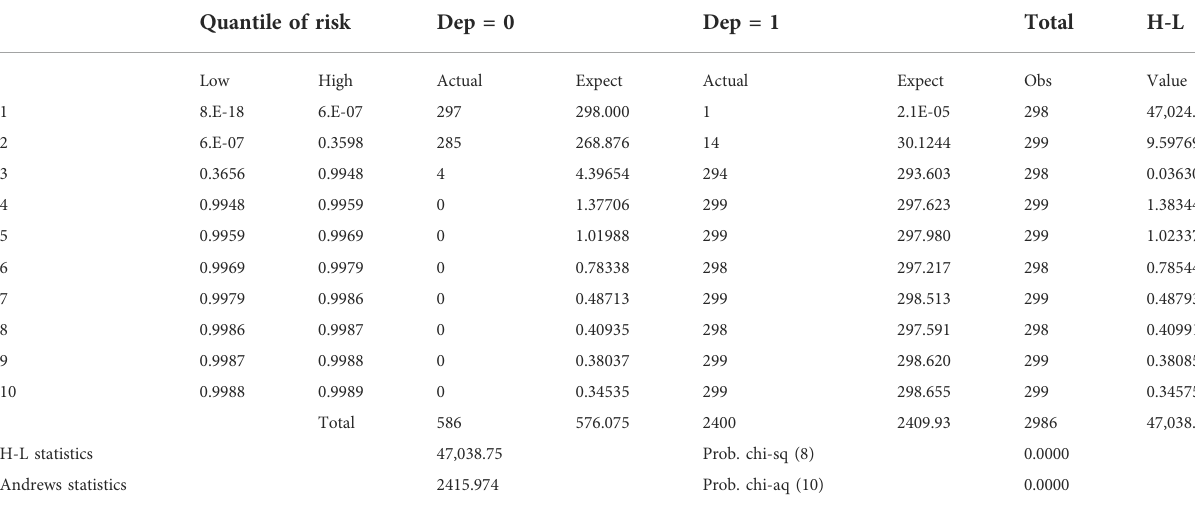
TABLE 4 Goodness-of- fi t evaluation for binary speci fi